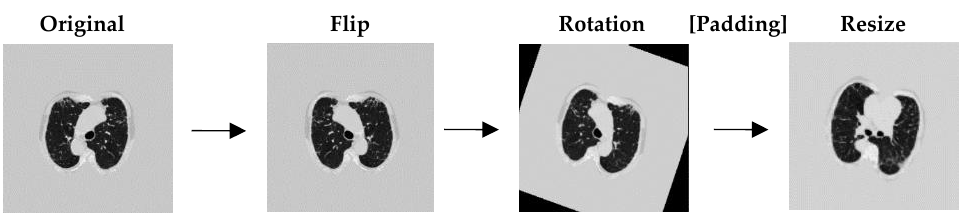
Figure 7. Data augmentation.